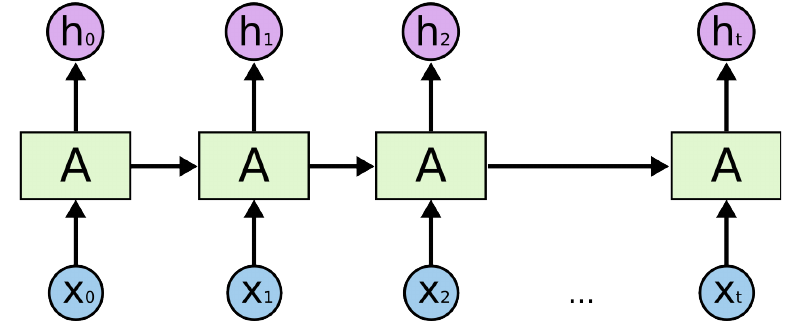
Figure 6. Activity sequence and recurrent neural network (RNN)